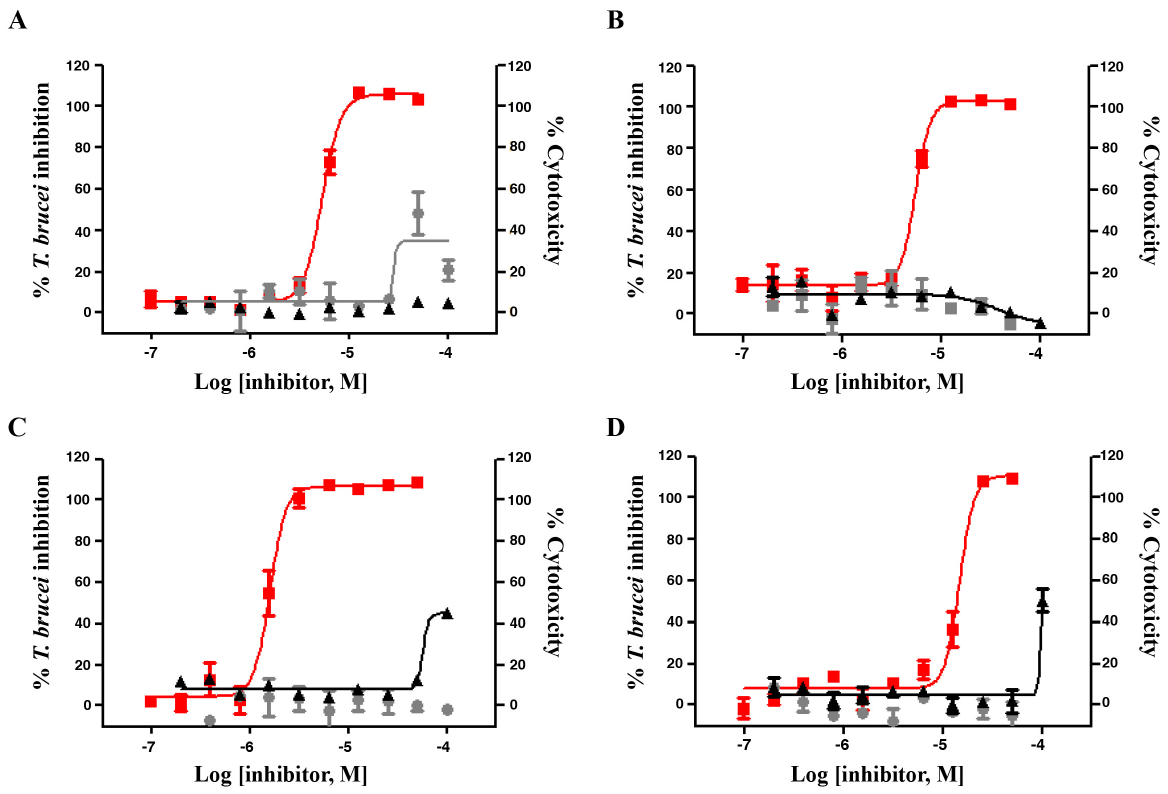
Figure 3. Inhibitory activity against T . brucei (red) and cytotoxic activity on HEK293T (grey) and HepG2 (black) cells of compounds 1 ( A ), 2 ( B ), 3 ( C ), and 4 ( D